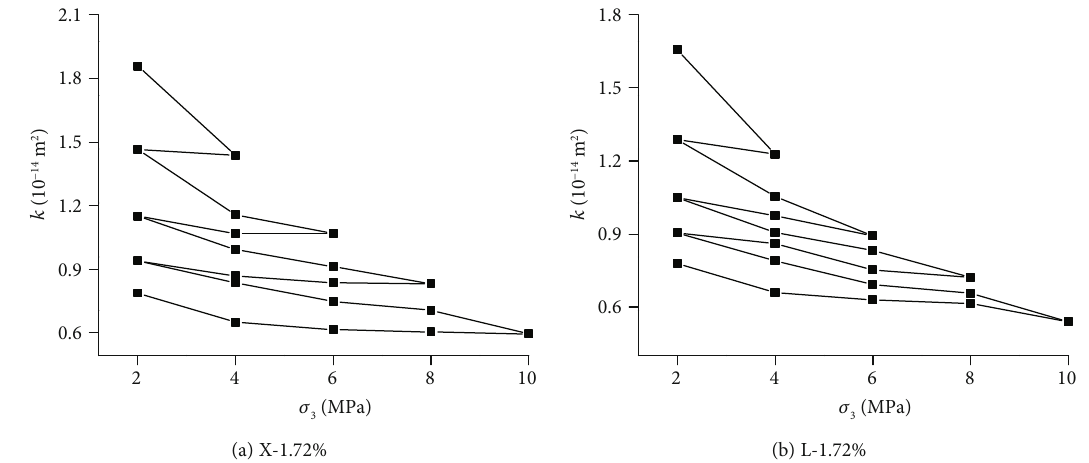
Figure 16: The permeability evolution during the loading-unloading process with the axial strain 1.72%.